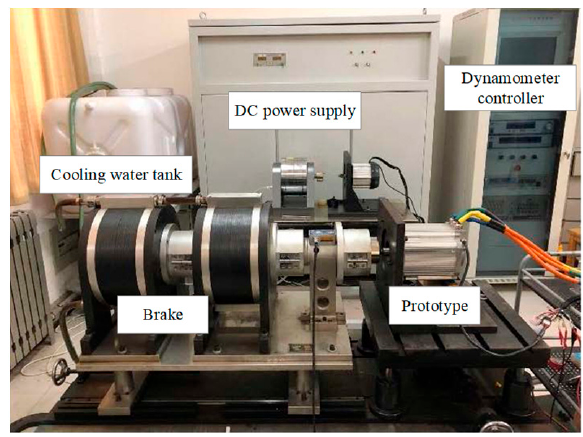
Figure 14. Motor test bench.